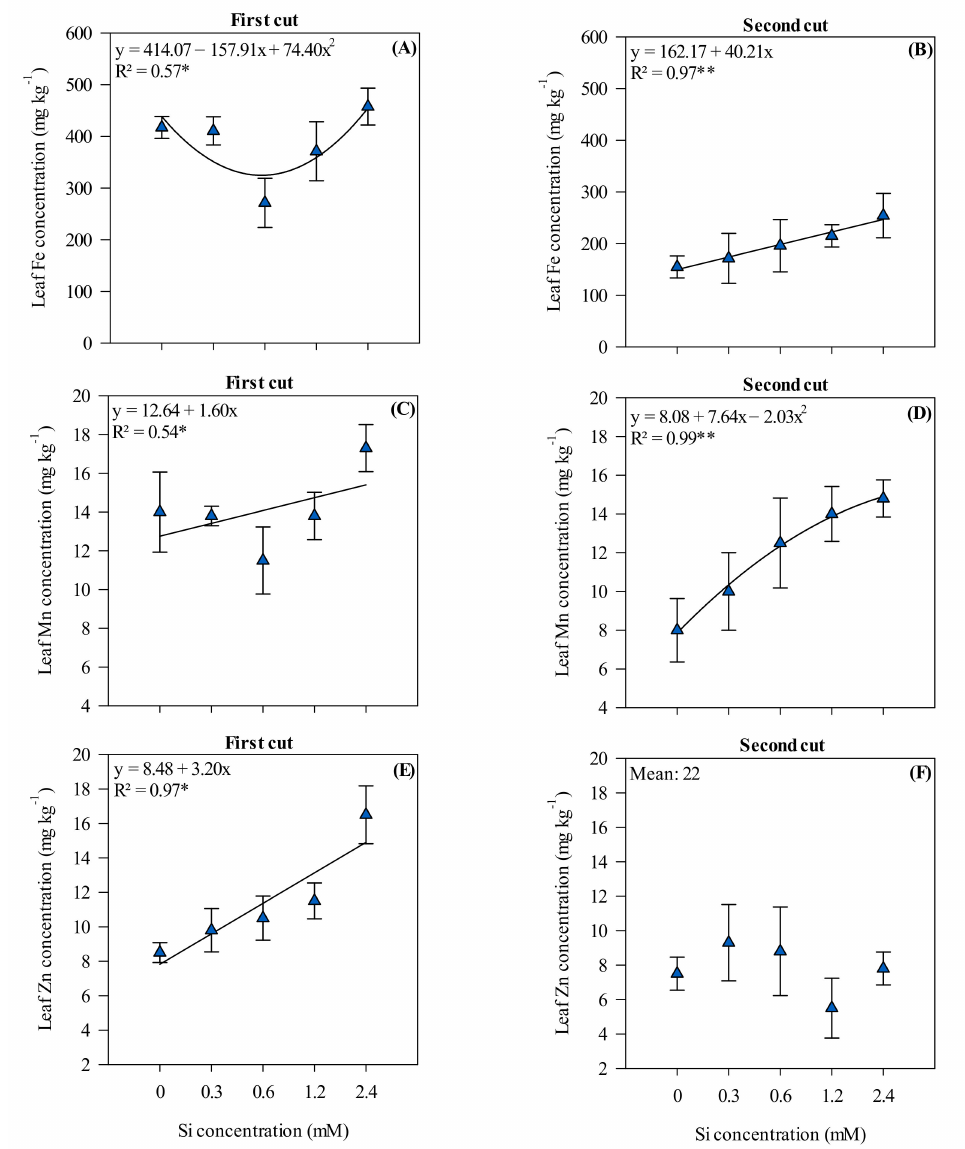
Figure 6. Leaf Fe concentration in the first ( A ) and second cut ( B ), leaf Mn concentration in the first ( C ) and second cut ( D ), leaf Zn concentration in the first ( E ) and second cut ( F ) as a function of increasing Si concentrations in Xara é s palisadegrass. Error bars indicate the standard deviation of the mean ( n = 4). * and ** = significant at 5 and 1% probability by F test